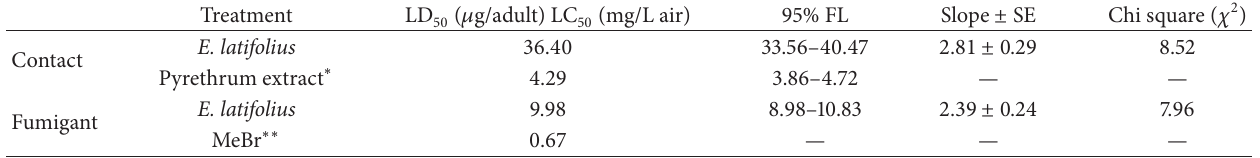
∗ Data from Li et al. [13]. ∗∗ Data from Liu and Ho